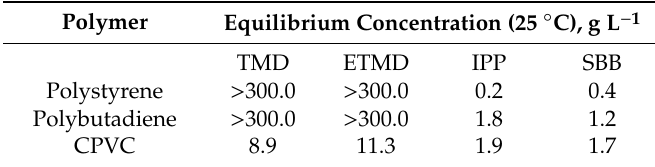
Table 12. The equilibrium solubilities of the organic polymers in the 1,2-PD and 2,3-BD derivatives. Polymer